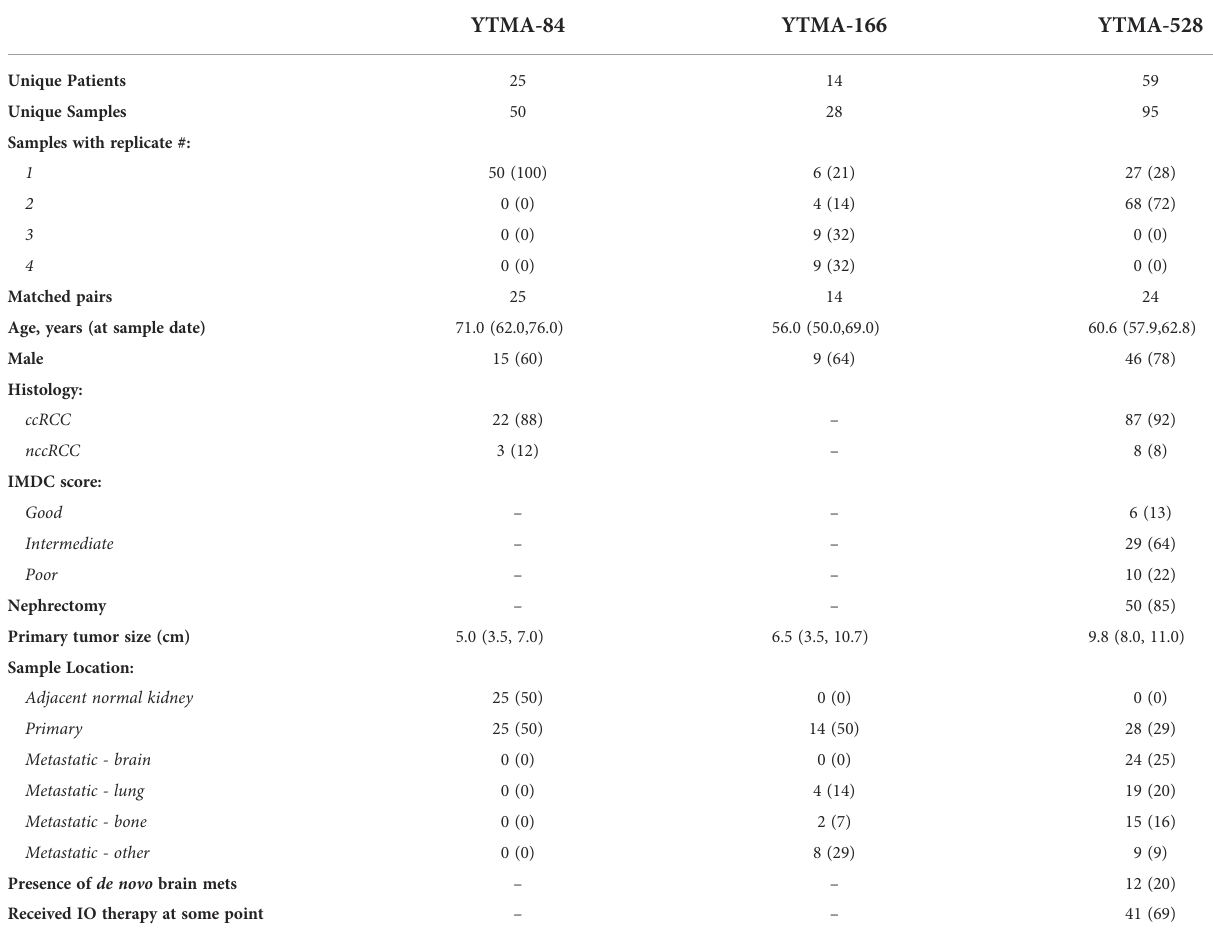
TABLE 2 TMA descriptive